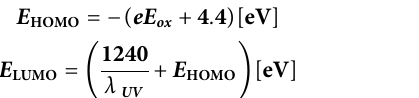
Frontiers in Chemistry |